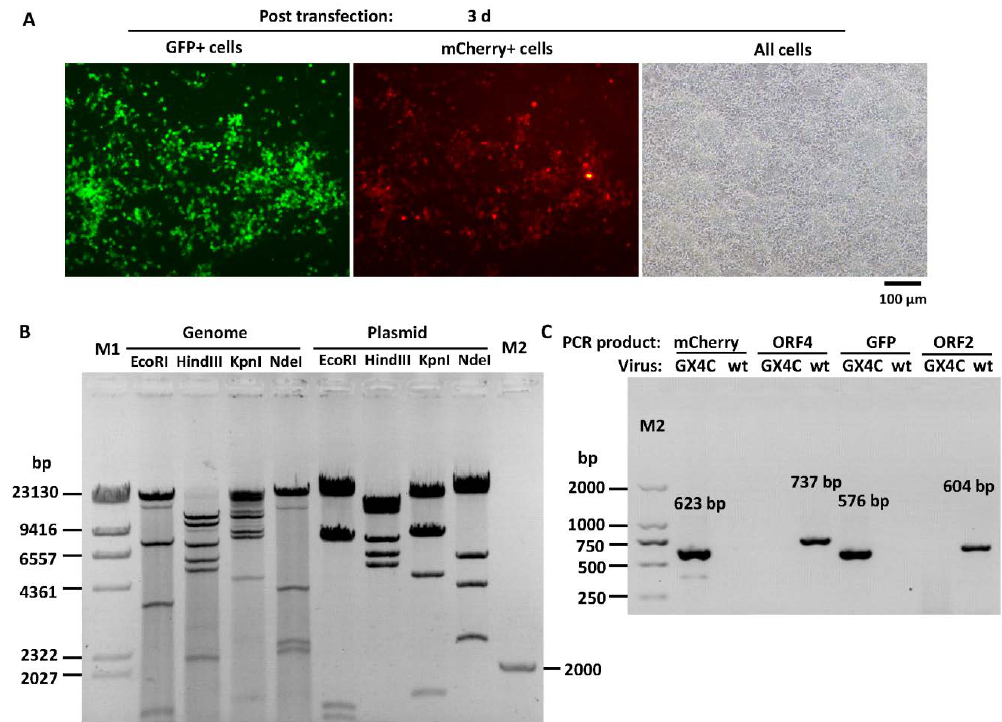
Figure 4. FAdV4-GX4C rescue and identification. ( A ) Rescue of recombinant fowl adenovirus FAdV4- FAdV4-GX4C. PmeI-linearized pKFAV4-GX4C was used to transfect LMH cells, and focuses GX4C. PmeI-linearized pKFAV4-GX4C was used to transfect LMH cells, and focuses formed by GFP-